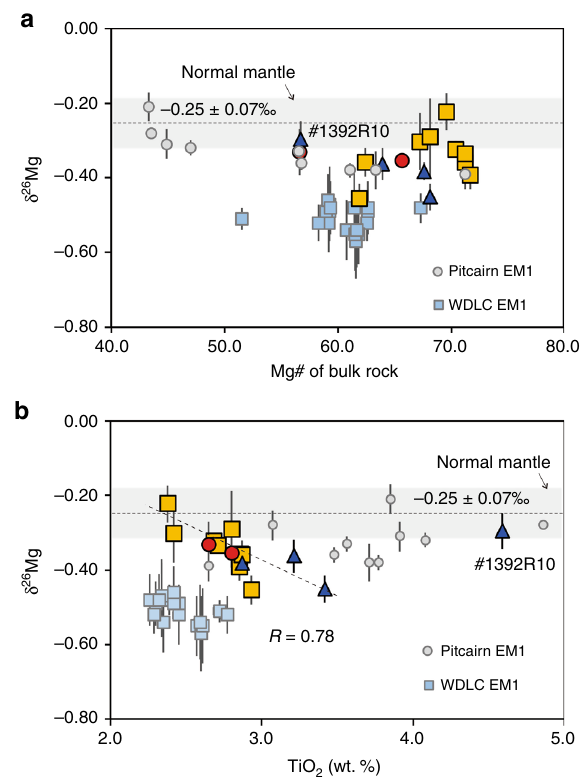
Fig. 3 δ 26 Mg vs. MgO and TiO 2 for petit-spot basalt samples. a The comparison of δ 26 Mg with bulk rock Mg#. The gray box with a dashed line shows the Mg isotopic composition of the global MORB and OIBs (ref. 21 ), referred to as the Normal Mantle value here. The Mg isotope composition of the Pitcairn Island EM1 basalts and the continental intraplate EM1 basalts from northeastern China (Wudalianchi, WDLC) are shown for comparison (ref. 39,41 ). All error bars represent 2 standard deviations. Symbols for petit- spot basalts are the same as in Fig. 2. #1392R10 marks the sample from Site C, which is out of the trend between δ 26 Mg and TiO 2 . b The comparison of δ 26 Mg with the TiO 2 content of the bulk rocks. All the symbols are the same to a and Fig. 2. R is the correlation coef fi cient of the linear regression for all the petit-spot basalt samples except #1392R10, which clearly stands outside the basalts (2.72 ± 0.17 wt.% vs. >6 wt.% 31 ). Second, because the partition coef fi cients of Nb and Zr are lower than those of Ta and Hf for ilmenite in ma fi c magmas 32 , one would expect negative correlation of TiO 2 between Nb/Ta and Zr/Hf if the mantle source contained a lot of ilmenite, but these are not observed.